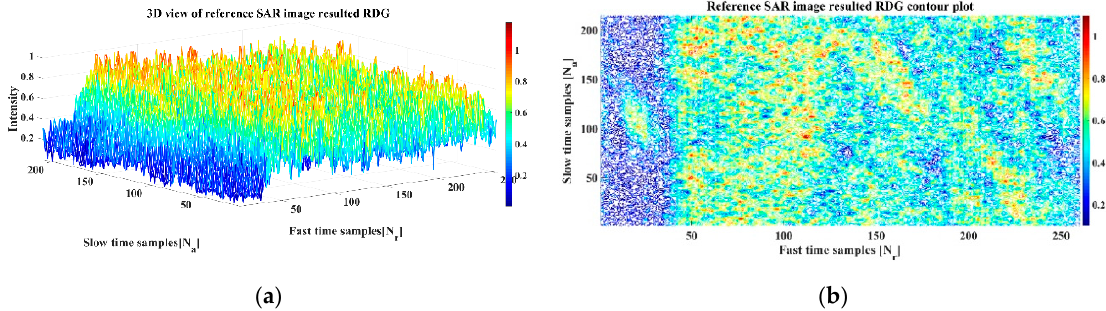
Figure 7. Resulting RDG of the reference image ( a ) RDG 3-D plot; ( b ) RDG contour plot.